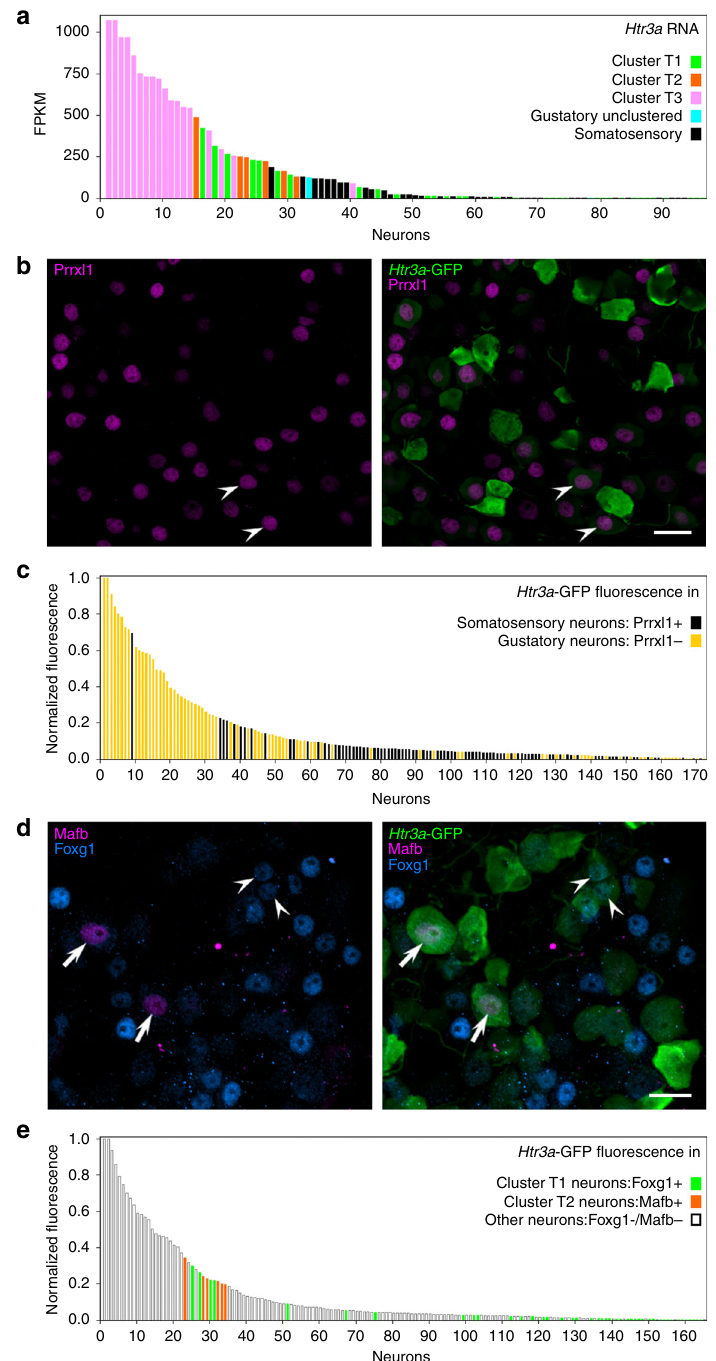
Fig. 7 Htr3a does not mark a natural grouping of neurons. a . Bar graph of FPKM values for Htr3a in 96 sequenced neurons. Bars are colored according to the sub-cluster identity of each neuron according to HCA (Figs. 2a, 4a). b . Cryosection of geniculate ganglion from Htr3a -GFP mouse, immunostained for Prrxl1. Some somatosensory neurons in the ganglion are GFP+( fi lled arrowhead). c . Native GFP fl uorescence was quanti fi ed (using Image J) in Htr3a- GFP ganglion cryosections similar to b . GFP fl uorescence intensity is a continuum and is displayed for Prrxl1+(somatosensory, black) and Prrxl1-negative (gustatory, yellow) neurons. d . Cryosection of ganglion from Htr3a- GFP mouse, immunostained for Foxg1 and Mafb (markers for sub-clusters T1 and T2, respectively). GFP+ neurons are seen with unstained nuclei, with Foxg1-immunoreactive (arrow) or Mafb-immunoreactive ( fi lled arrowhead) nuclei. Here, only the brightest Mafb+ (i.e. T2) neurons can be seen. e . Native fl uorescence of GFP was quanti fi ed in all neurons in sections similar to d . GFP intensity in T1 and T2 neurons is displayed in colors assigned previously. Bar graphs in a , c and e show that Htr3a expression does not demarcate a speci fi c group of neurons in the ganglion. Scale bars , 20 µ